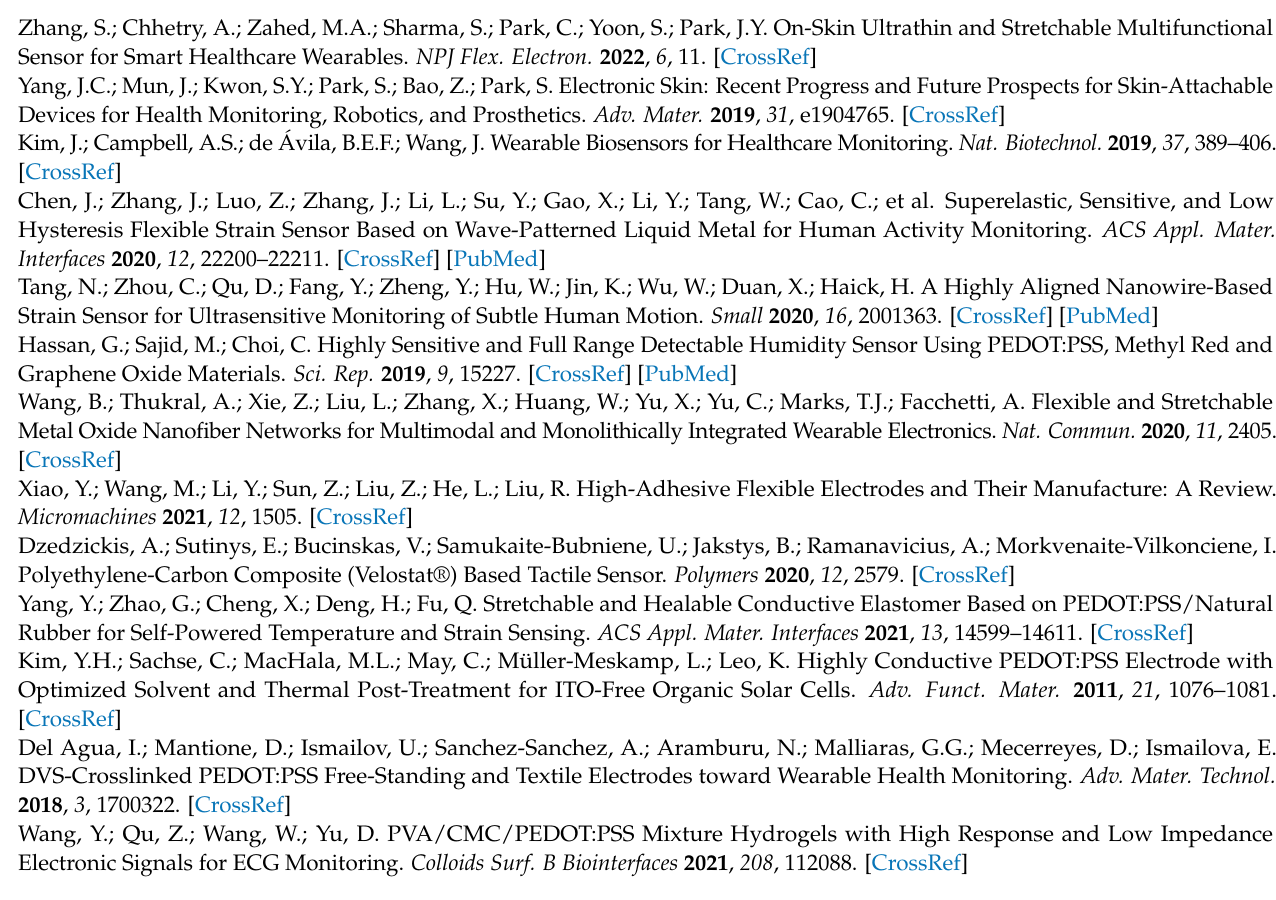
Figure S3: Sheet resistance of the CMC-PEDOT:PSS film (CMC:DMSO = 1:11 and CMC:glycerol = 1:5) as a function of the ratio of CMC to PEDOT:PSS; Figure S4: Sheet resistance of CMC-PEDOT:PSS film (CMC:PEDOT:PSS = 1:13 and CMC:glycerol = 1:2) as a function of the ratio of CMC to DMSO; Table S1: Cellulose-PEDOT-based composites and their electrical conductivities. References [19–26] are cited in the supplementary